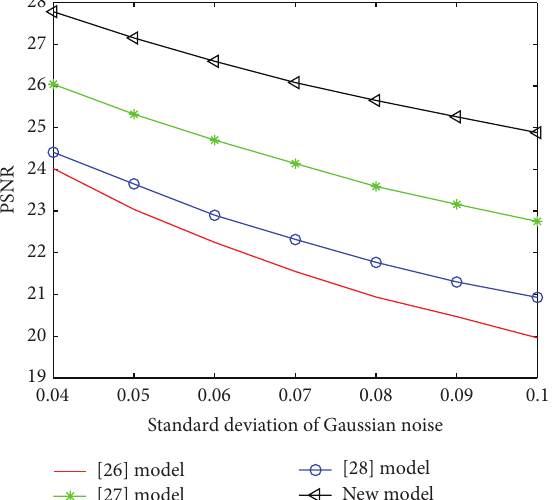
Figure 9: PSNR (dB) graph of [26–28] and new algorithms for various Speckle noises for Miss America video sequence.